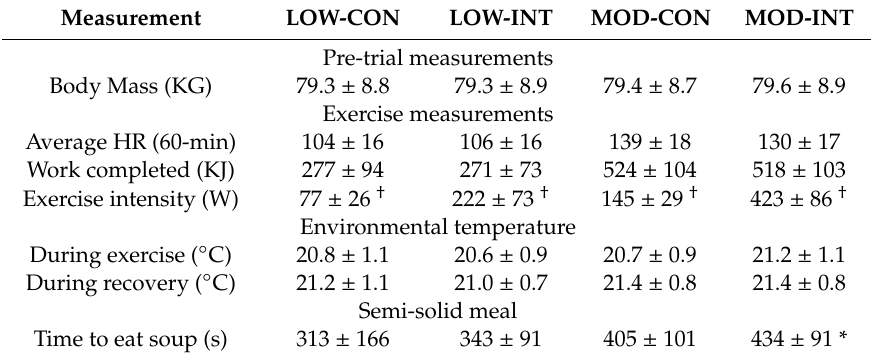
Table 2. Standardisation measurements for each variable during laboratory